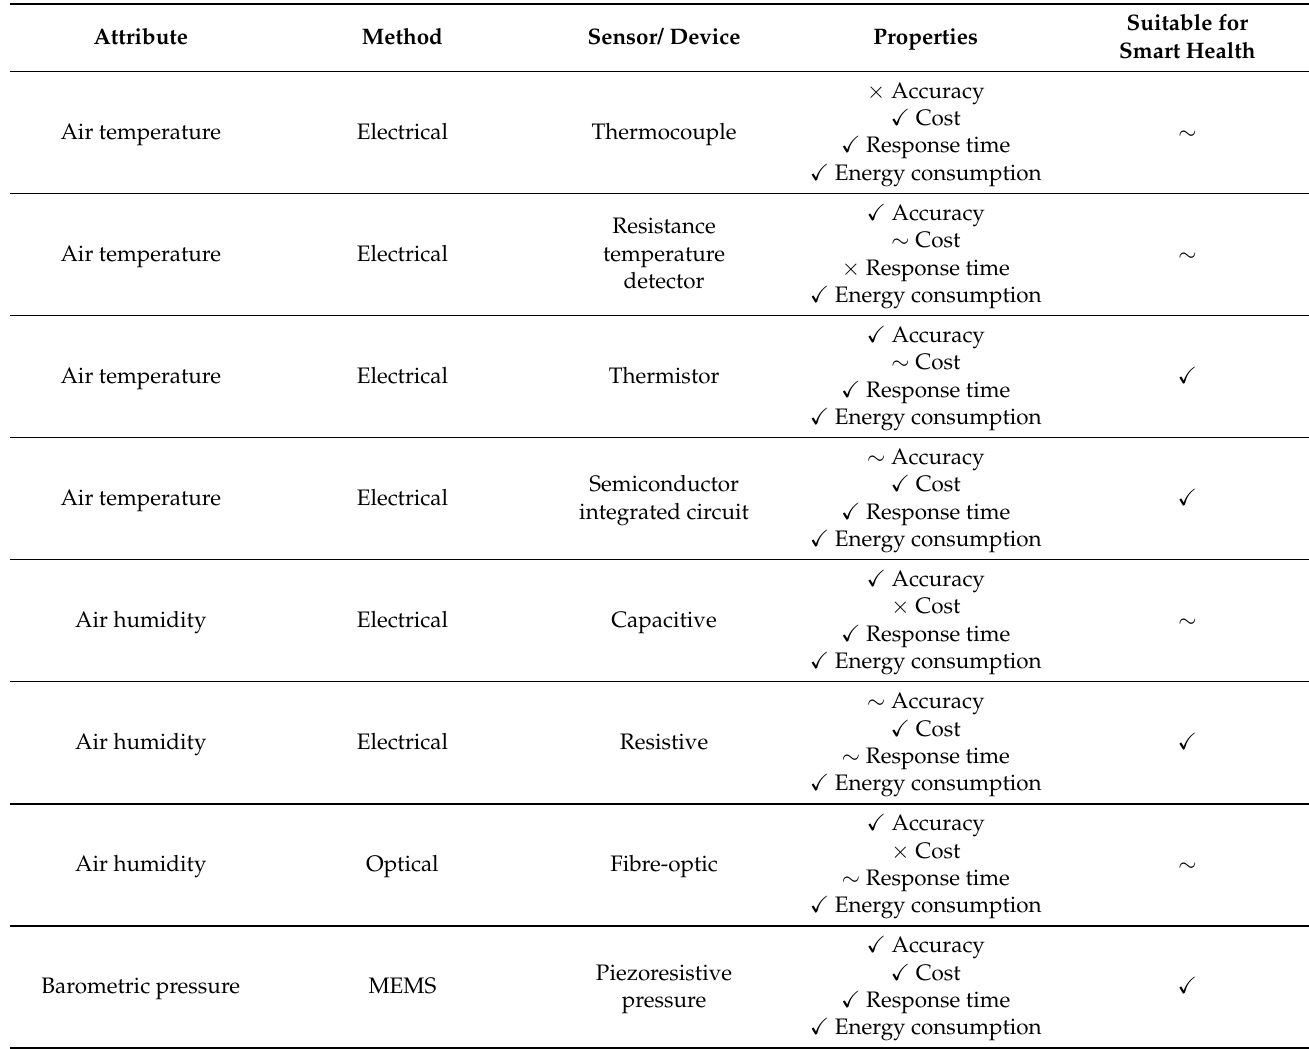
Table 8. Characteristics of the methods for air temperature sensing, air humidity sensing and barometric pressure sensing. Attribute Method Sensor/ Device